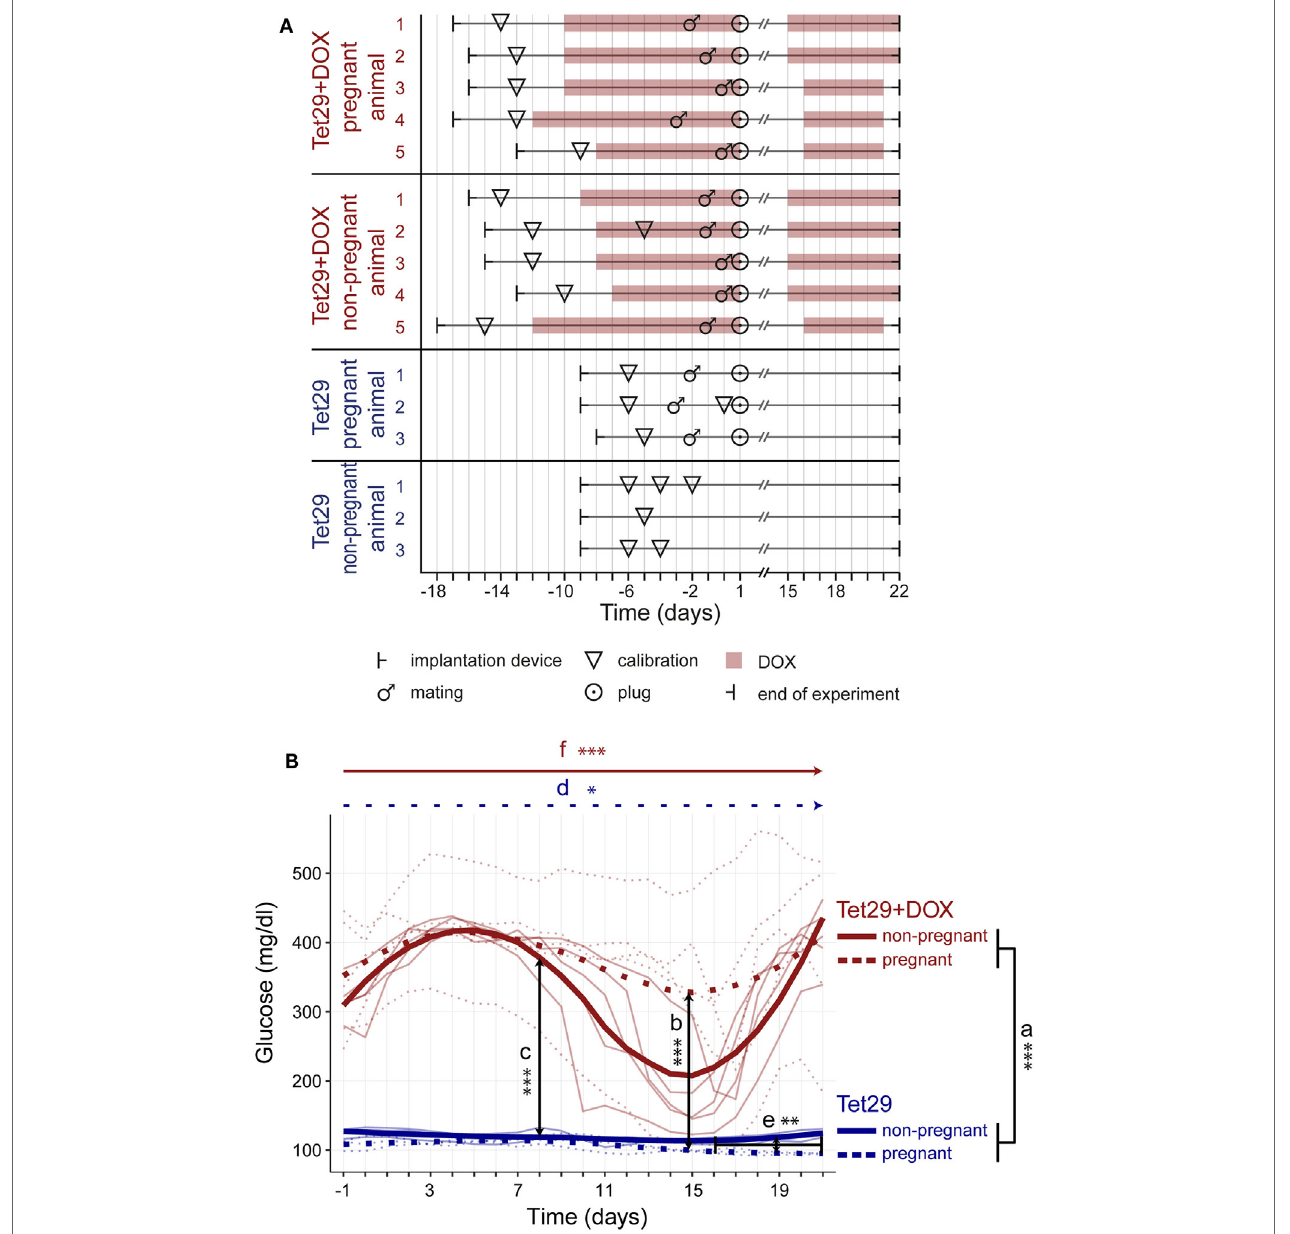
FigUre 1 | Experimental design and continuous blood glucose monitoring during pregnancy. (a) Shown is the experimental design of each rat participating in the study; DOX = Doxycyclin. (B) Shown is the mean blood glucose course of each rat per group over time; n = 3 non-pregnant Tet29 rats, n = 3 pregnant Tet29 rats, n = 5 non-pregnant Tet29 + DOX rats, and n = 5 pregnant Tet29 + DOX rats. The bold line/symbols show the smoothed averaged course of all animals within a group (LOESS). The days refer to pregnancy or the corresponding period in non-pregnant animals. Tet29 rats were normoglycemic, Tet29 + DOX rats were hyperglycemic. (a) Tet29 + DOX rats, both pregnant and non-pregnant, had higher blood glucose values than Tet29 rats, both pregnant and non-pregnant (repeated measures ANOVA). (b) In addition, pregnant Tet29 + DOX rats had higher blood glucose values than pregnant Tet29 rats (repeated measures ANOVA), and (c) non-pregnant Tet29 + DOX rats had higher blood glucose values than non-pregnant Tet29 rats (repeated measures ANOVA). (d) Blood glucose values decreased during pregnancy in Tet29 rats (ANOVA). (e) In these rats, blood glucose values during late pregnancy were lower than the blood glucose values of non-pregnant Tet29 rats in the corresponding period ( post-hoc comparison). Pregnancy did not have an influence on mean blood glucose values in diabetic Tet29 + DOX rats (repeated measures ANOVA; post-hoc comparison), but there is (f) a significant change in blood glucose values over time in non-pregnant Tet29 + DOX rats